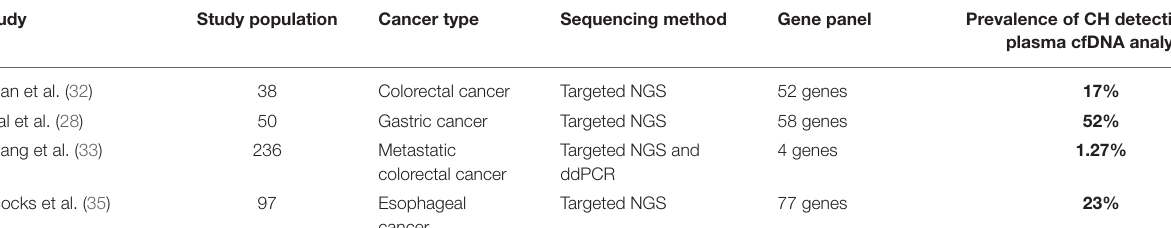
TABLE 1 | Summary of published studies on the prevalence of CH mutations from plasma cfDNA analysis in patients with GI cancers.